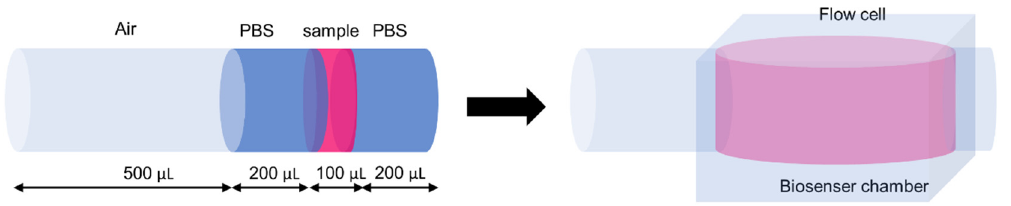
Figure 9. A SI sequence profile for amperometric determination of glucose in culture media.